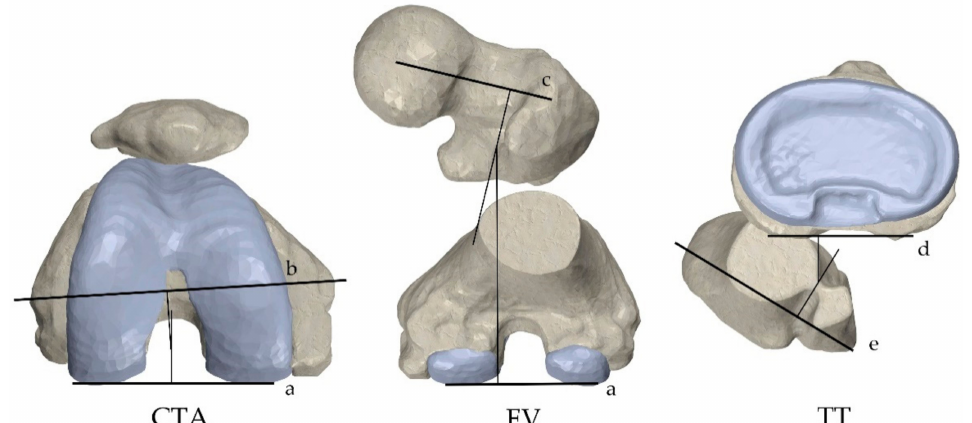
Figure 1. Measurement of angular values in the axial plane on the 3D virtual model of the total knee arthroplasty (TKA). CTA: the condylar twist angle is the angle between the posterior condylar line ( a ) and the clinical transepicondylar axis ( b ). FV: the femoral version is the angle between the femoral neck axis ( c ) and the posterior condylar line ( a ). TT: the tibial torsion is defined as the angle between the line connecting the posterior cortices of the proximal tibial condyles ( d ) and the line connecting the most prominent points of the medial and lateral malleolus ( e